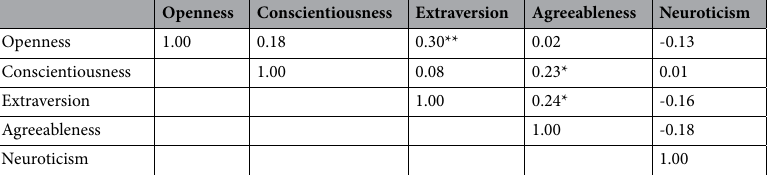
Table 2. Correlation table for the Big Five personality traits, as observed in the participant sample. Significance levels are indicated with asterisks.